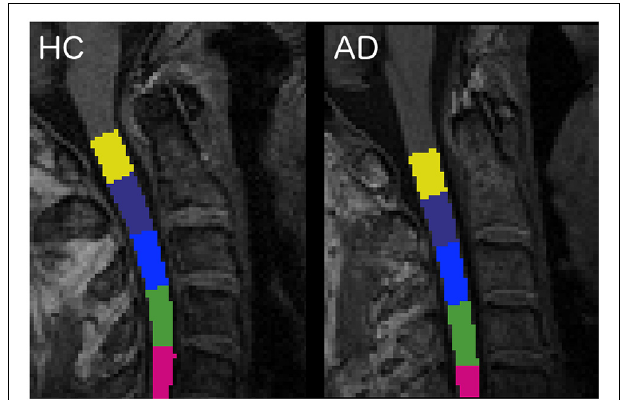
FIGURE 1 | Labeled vertebrae in two randomly chosen subjects: an healthy control (HC) subject on the left and an Alzheimer’s disease (AD) patient on the right (slice n = 96, sagittal plane). Each color represents a different vertebra from C1 (yellow) to C5 (fuchsia).